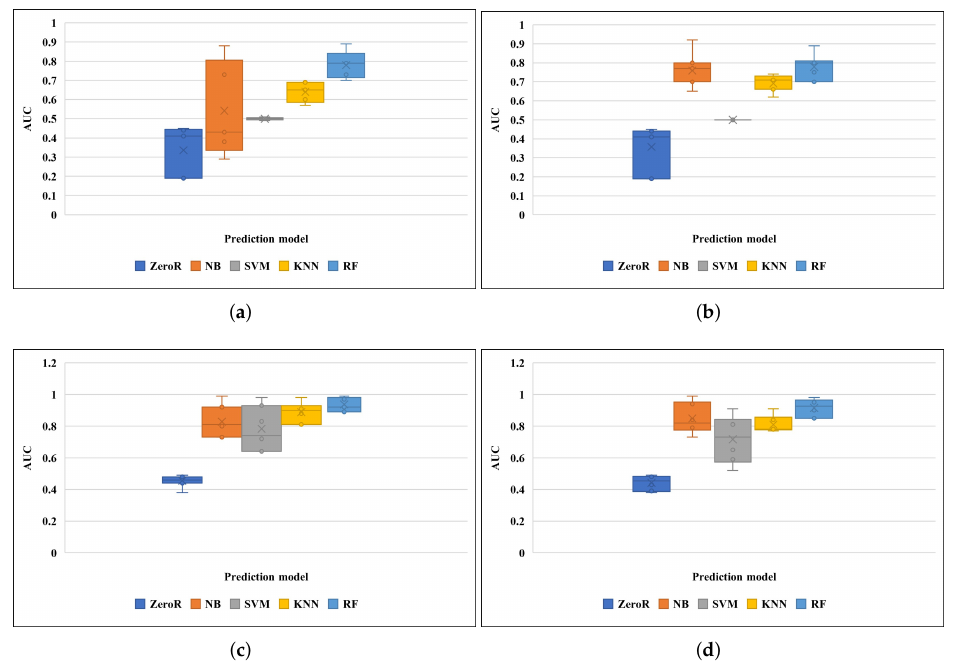
Figure 3. ( a ) Box plot of the AUC for prediction models on the first scenario. ( b ) Box plot of the AUC for prediction models on the second scenario. ( c ) Box plot of the AUC for prediction models on the third scenario. ( d ) Box plot of the AUC for prediction models on the third